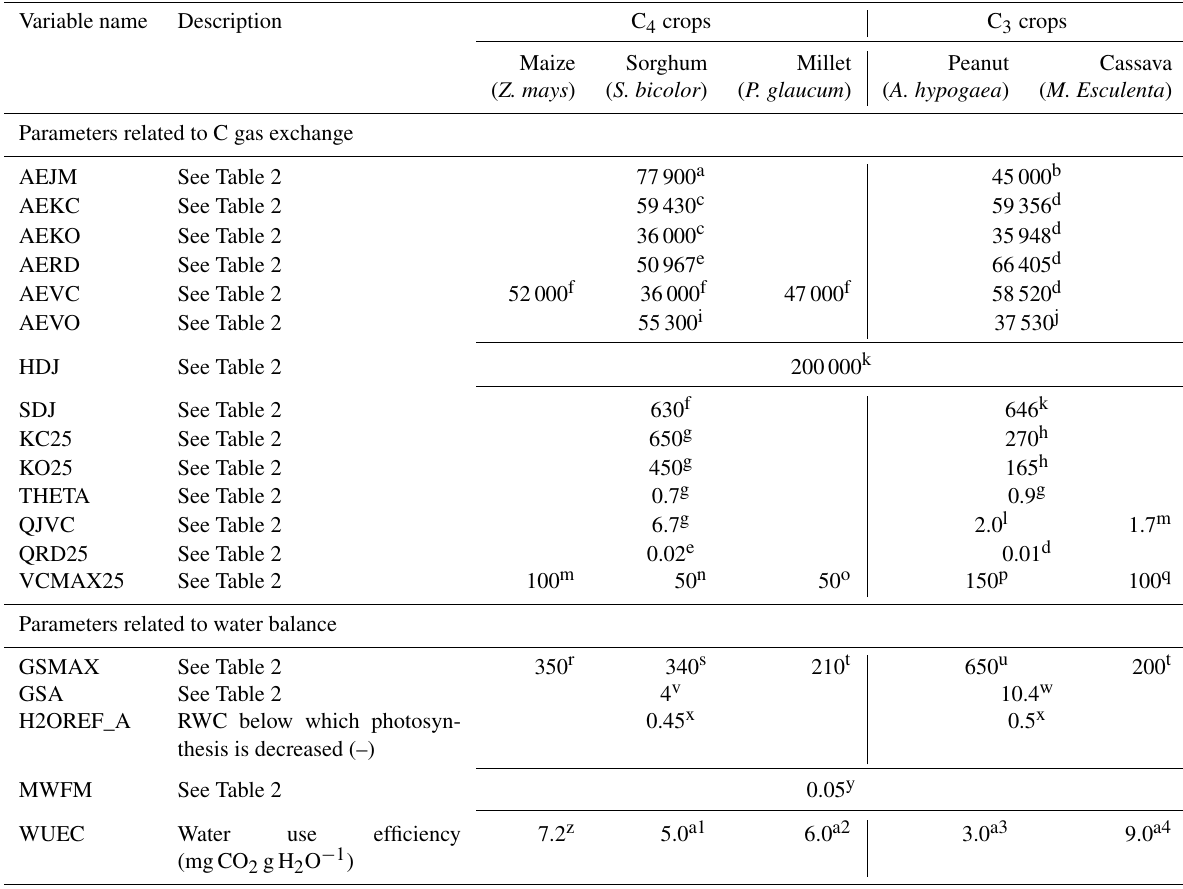
Table 3. Plant parameters affecting the C and water exchange in the PlaMo x vegetation model used for simulating biomass growth and yield at the agricultural